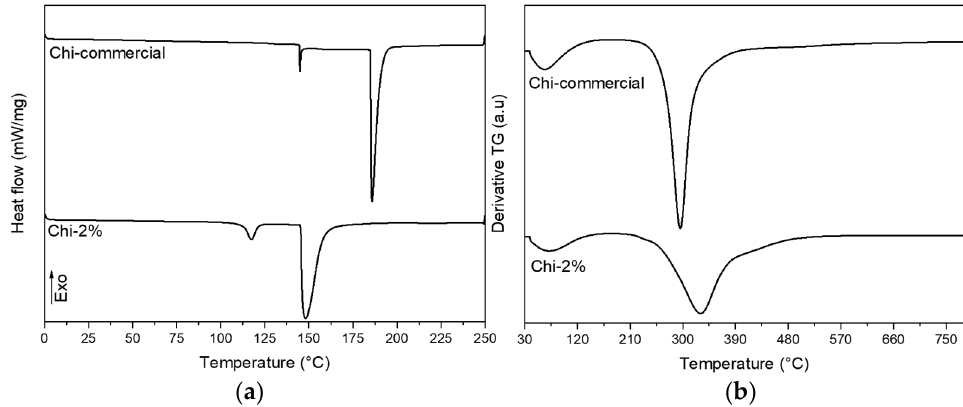
Figure 5. ( a ) DSC and ( b ) DTG thermograms of commercial chitosan and chitosan obtained from P. magdalenae scales. Table 3. Parameters extracted from DSC analysis of commercial chitosan and chitosan obtained from P. magdalenae scales.